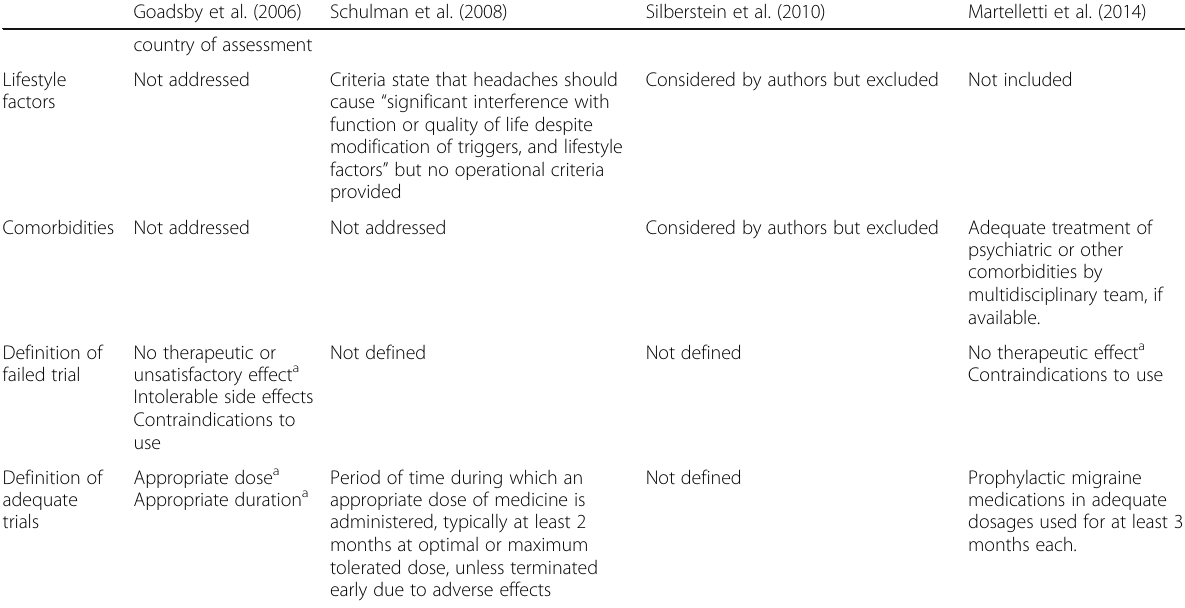
Table 1 Overview of the published proposal for refractory or intractable migraine (Continued) Goadsby et al.